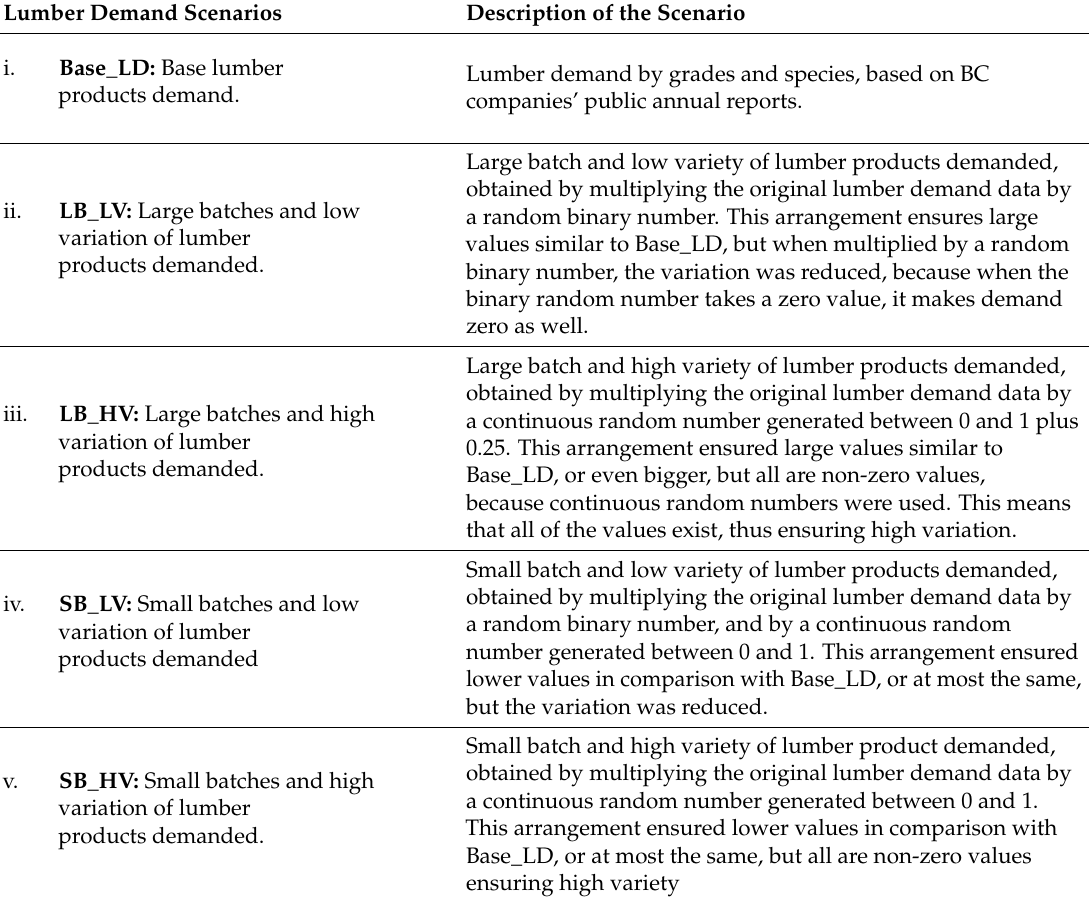
Table 3. Lumber demand scenarios